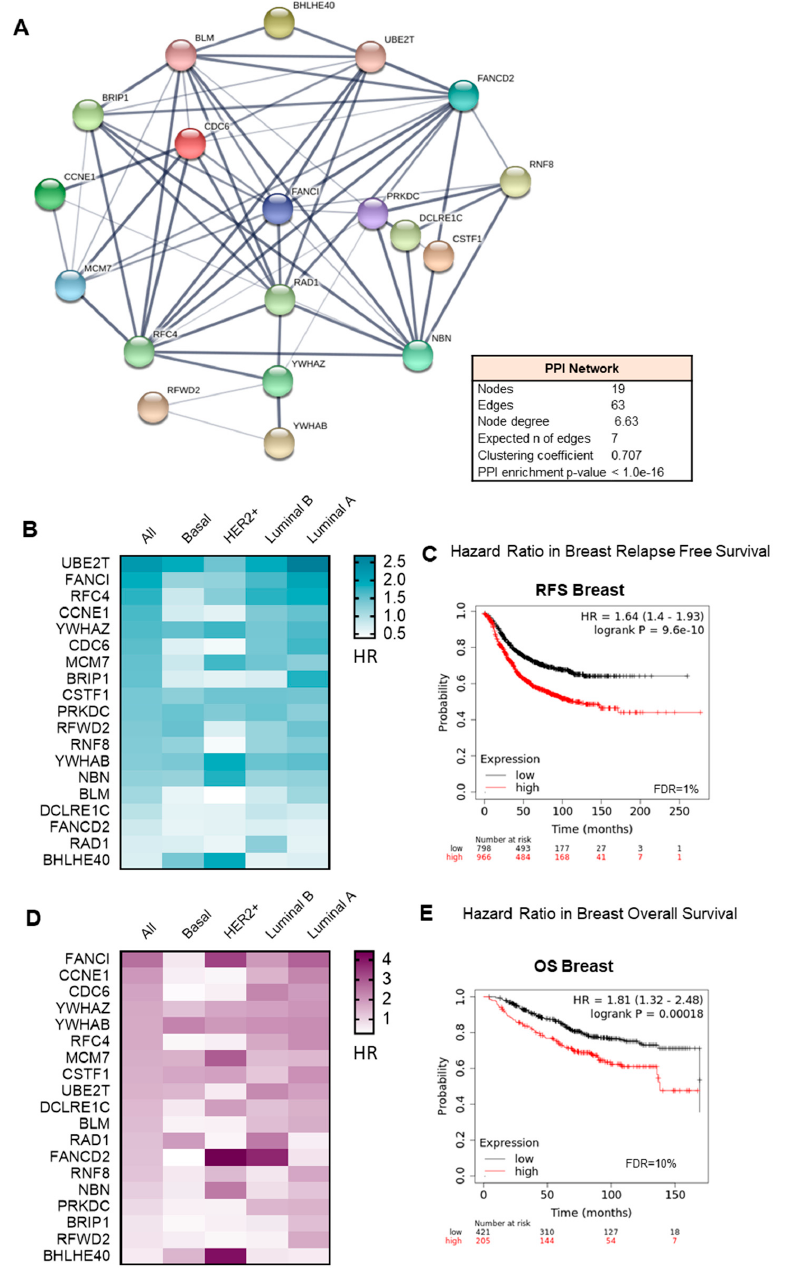
Figure 3. PPI map and functional annotation of bad prognosis-associated upregulated genes in breast cancer patients. ( A ) Protein–protein interaction map displaying the significant functional network integrated by the selected genes. ( B ) Heatmap showing the HR of the expression of individual genes for the relapse free survival (RFS) in breast cancer and its subtypes. ( C ) Association with RFS of combined genes in breast cancer. ( D ) Same as B, but for overall survival (OS). ( E ) Same as C for